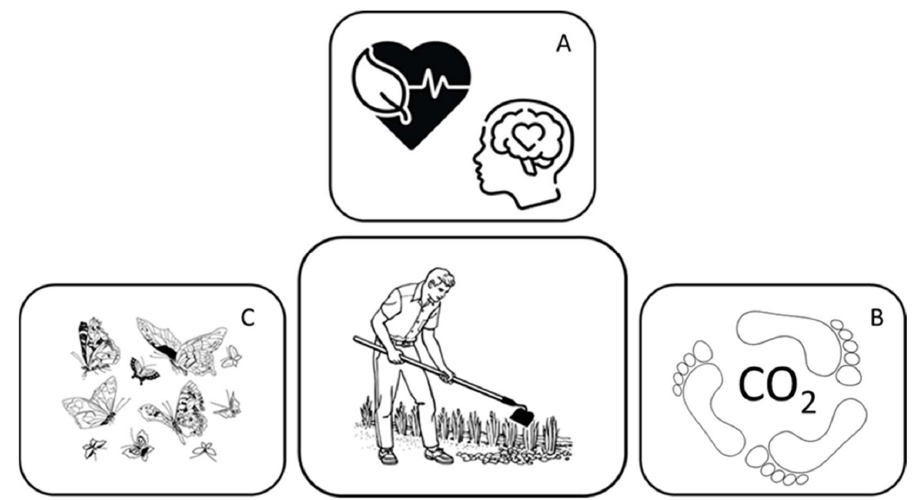
Figure A1. The three features associated with gardening activities discussed in this viewpoint: ( A ) Wellbeing and health; ( B ) Nutrition and carbon footprint reduction; ( C ) Biodiversity and nature conservation.